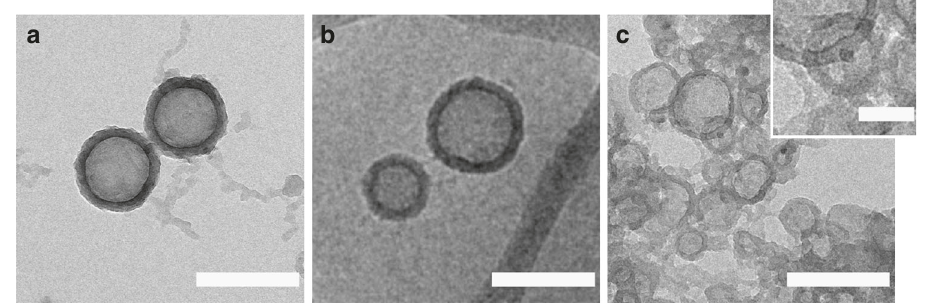
Fig. 4 Microscopy of PDA-coated nanocapsules. a Transmission electron microscopy (TEM) and b cryo-TEM micrographs of polydopamine – fructose- curcumin (PDA – Fru – CCM) capsules before dissolution in organic solvent (methanol) and c TEM micrograph after dissolution in organic solvent and subsequent removal of curcumin membrane from polydopamine shells. Scale bars in a – c are 200 nm, scale bar inset in c is